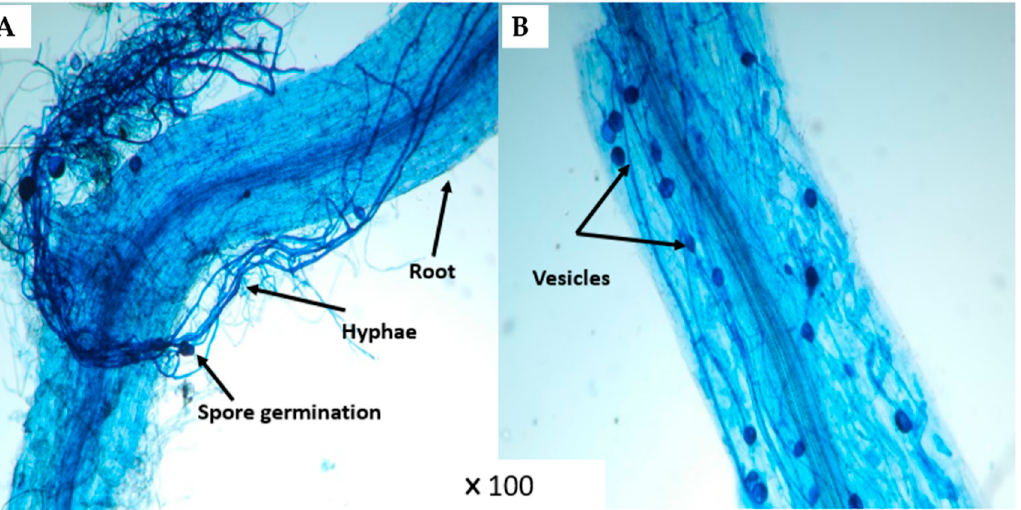
Figure 2. Microscopic observation (×100) of mycorrhizal structures in ( A ) CM and ( B ) CMR treat- ments of lettuce root.